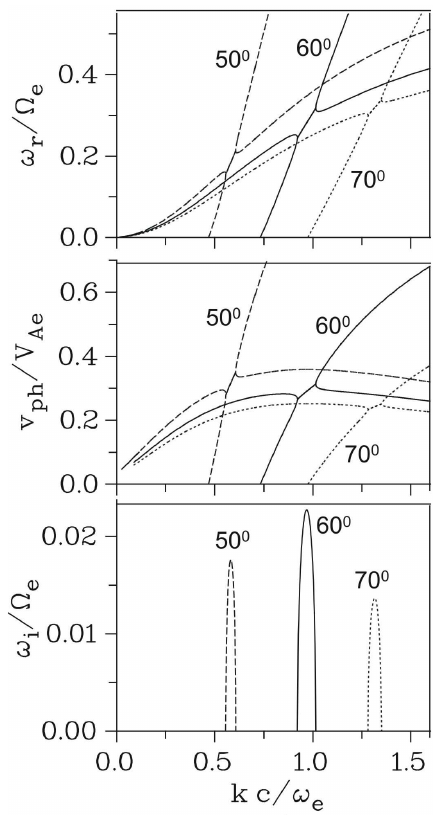
Fig. 2. The same as in Fig. 1, but for different propagation an- gles. The growth rate has a maximum at θ = 60 ◦ which appears at kc/ω e ≈